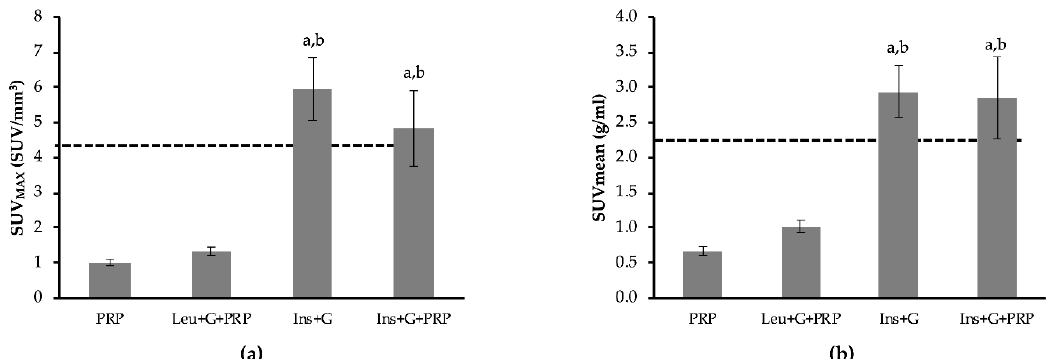
Figure 3. The effect of inhibiting β-adrenergic activation of interscapular brown adipose tissue (IBAT) on 2-deoxy-2-(fluorine-18)fluoro- D -glucose ( 18 F-FDG) uptake. β-adrenergic activation was inhibited by pretreatment with propranolol (PRP). Dashed line represents SUV MAX for control/untreated animals. Pretreatment with PRP reduced 18 F-FDG uptake to 23.6% of control. Following pretreatment with PRP, mice were either untreated (PRP), or treated with leucine and glucose (Leu + G + PRP) or insulin and glucose (Ins + G + PRP). SUV is also reported for insulin and glucose together, without PRP (Ins + G). (a) Group mean data for the maximum SUV (SUV MAX , units in SUV/mm 3 ) was calculated for IBAT for each treatment group. (b) Group mean data for the average SUV across the entire tissue (SUVmean, units in g/mL). Data are expressed as mean ± the SEM. A one-way analysis of variance was performed followed by a Fisher LSD post-hoc. a, denotes significant difference compared to PRP; b, denotes significant difference compared to Leu+G+PRP ( p ≤ 0.05). n = 7 for PRP and Leu+G+PRP. n = 3 for Ins+G and Ins+G+PRP. n = 6–7 for PRP and Leu+G+PRP. n = 3 for Ins+G and Ins+G+PRP.